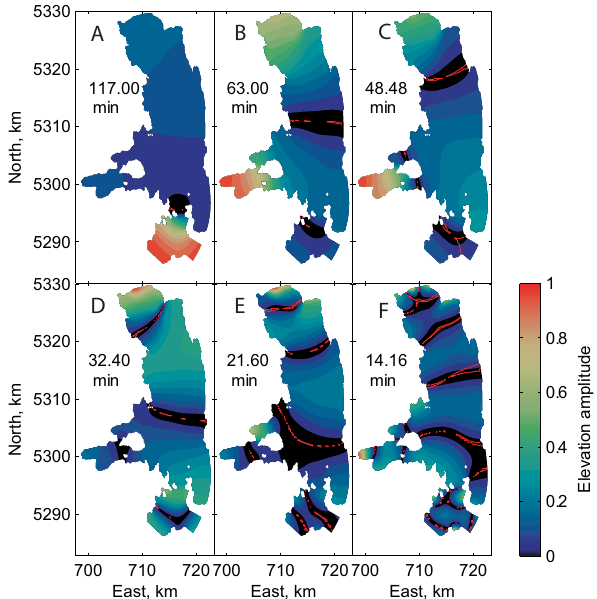
Figure 4. Relative amplitudes of the six lake-wide free oscillation modes. Zero-amplitude nodal lines are shown in